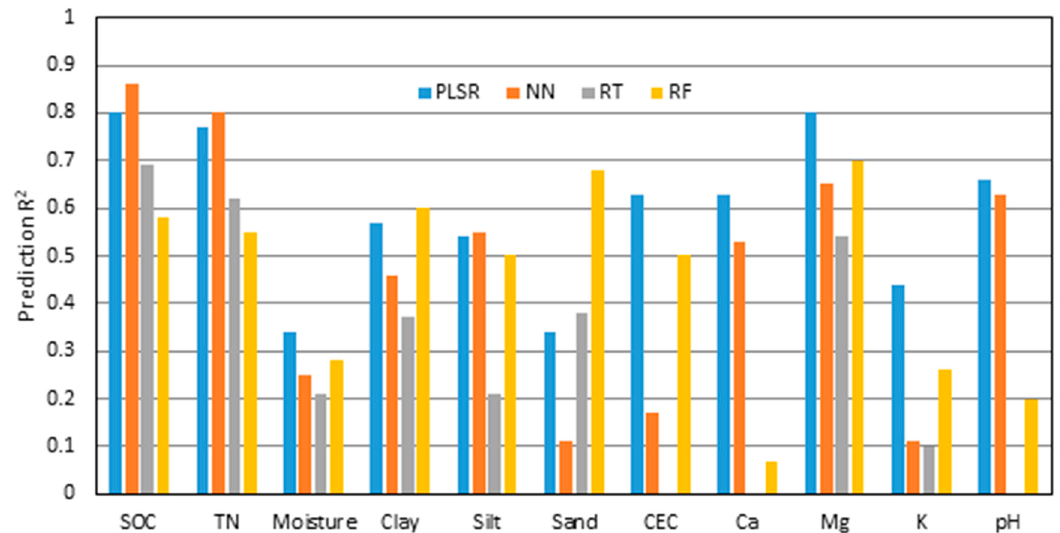
Figure 2. Prediction R 2 values comparing results obtained on the combined Field 1 and Field 3 depth, EC a , CI and spectra (DECS) dataset using partial least squares regression (PLSR), neural networks (NN), regression trees (RT), and random forests (RF) methods. Missing bars indicate that analysis did not converge to a solution.